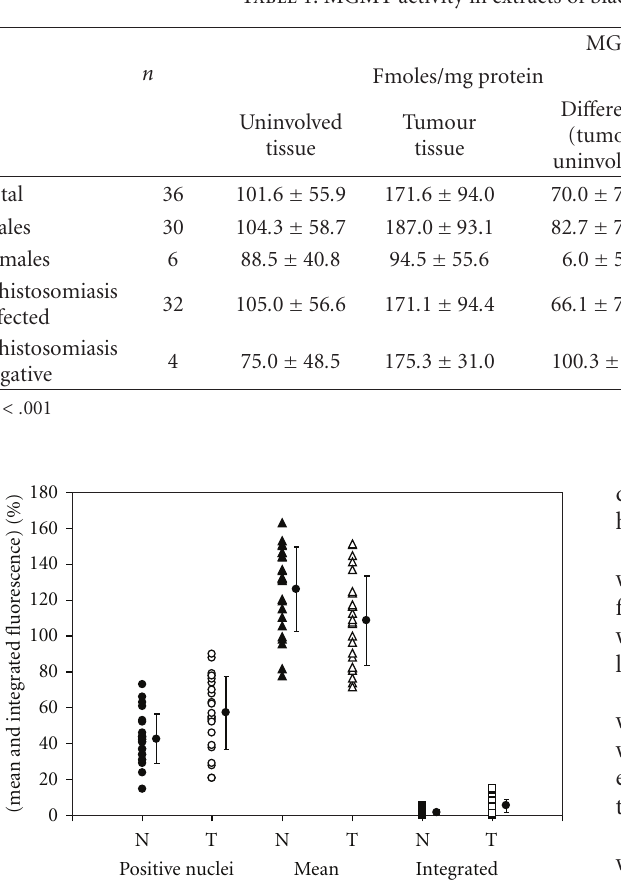
Table 1: MGMT activity in extracts of bladder tumours and uninvolved tissue.